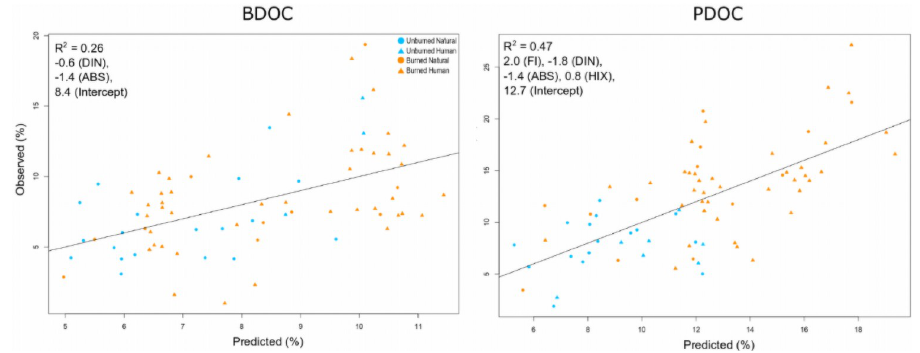
Fig 7. Predicted versus observed BDOC and PDOC based on the multiple linear regression with optical properties of DOM and background nutrients. Burn status and land use class are indicated by the color and shape of each